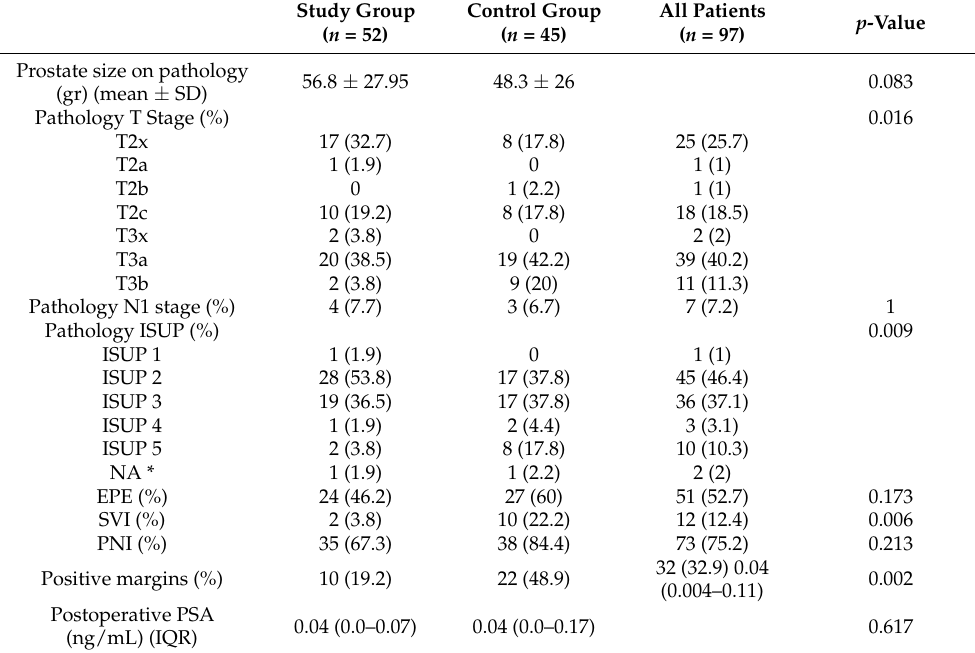
Table 3. Pathologic characteristics per group, per prostatectomy histology. Staging is defined per National Comprehensive Cancer Network